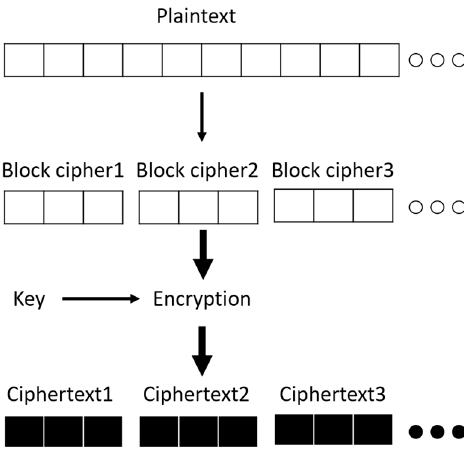
Figure 1. Operation diagram of ECB mode.